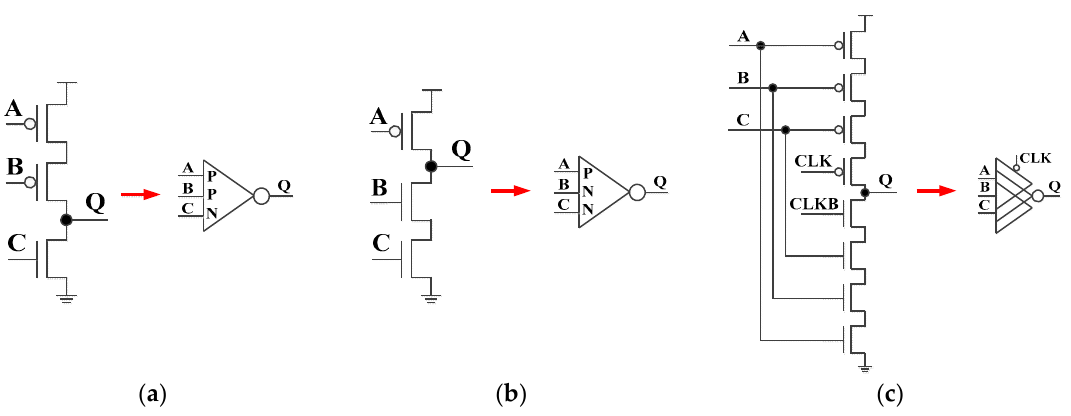
Figure 2. Schematic and symbol of ( a ) 2P1N inverter; ( b ) 1P2N inverter; ( c ) three-input Muller C-element (MCE) with clock gating (CG).